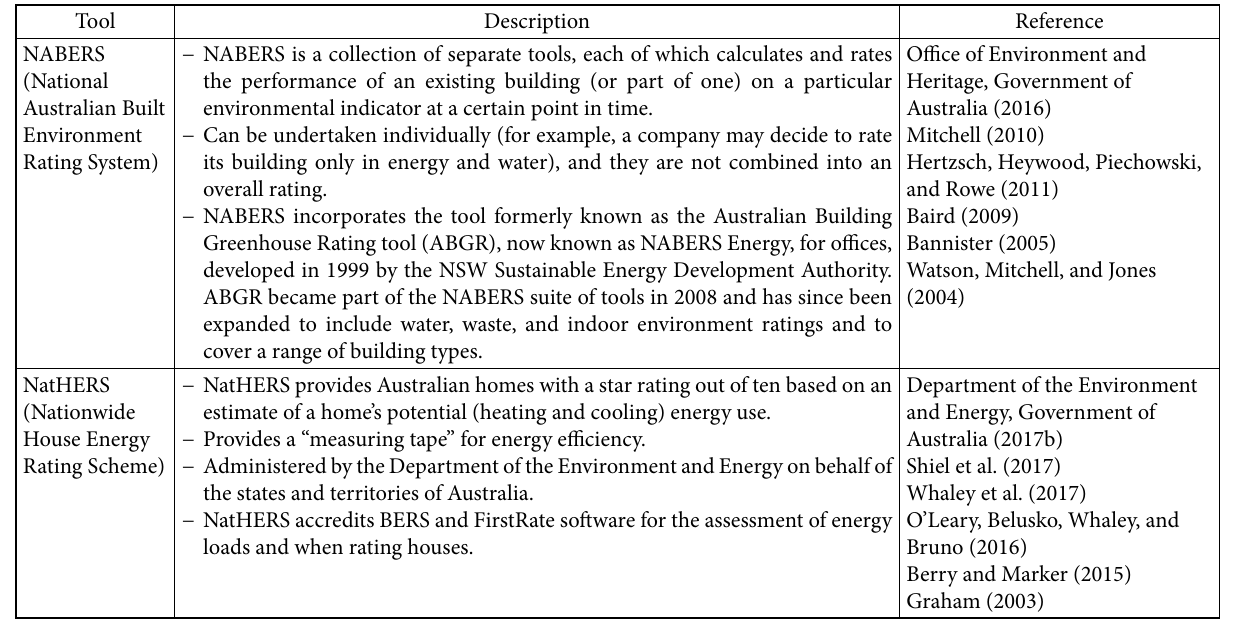
Table 3. Detailed evaluation of green building assessment and rating tools used in Australia